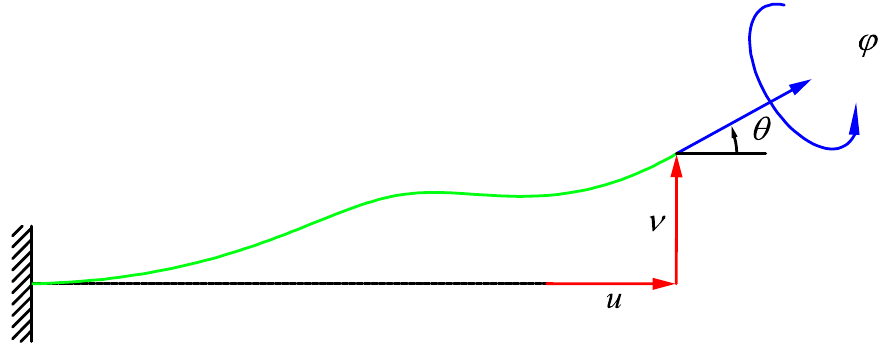
Figure 1. General deformation of a cantilever beam with axial and lateral displacements as well as flexural and torsional rotations at the free end.